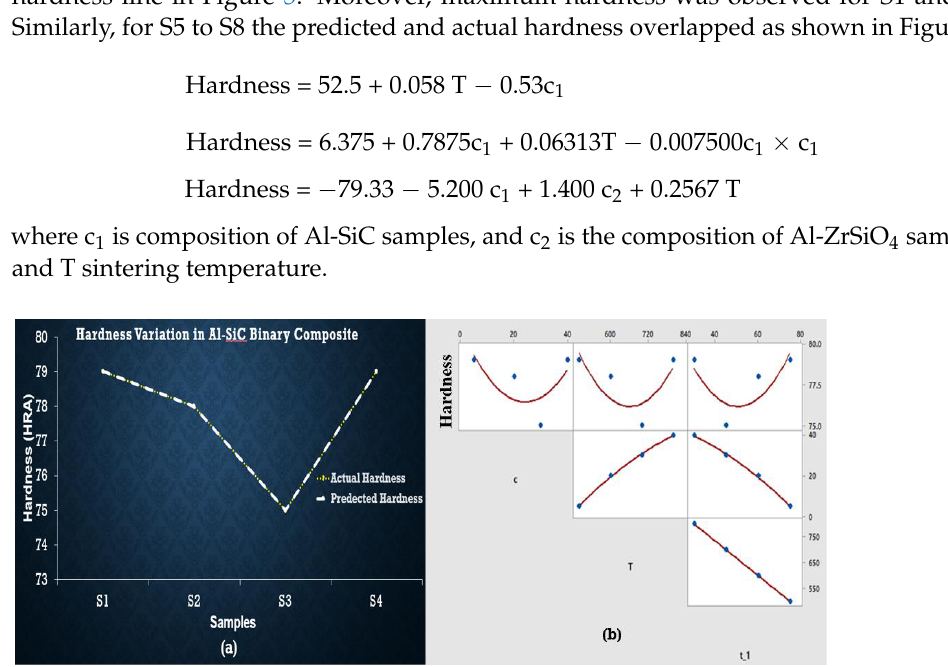
Figure 6. ( a ) Regression plot for Al-ZrSiO 4 showing overlapping of actual and predicted hardness values points (yellow dotted line presents actual value of hardness and white line shows predicted values). ( b ) Matrix plot showing the individual relationship between hardness and input variables for Al-ZrSiO 4 .